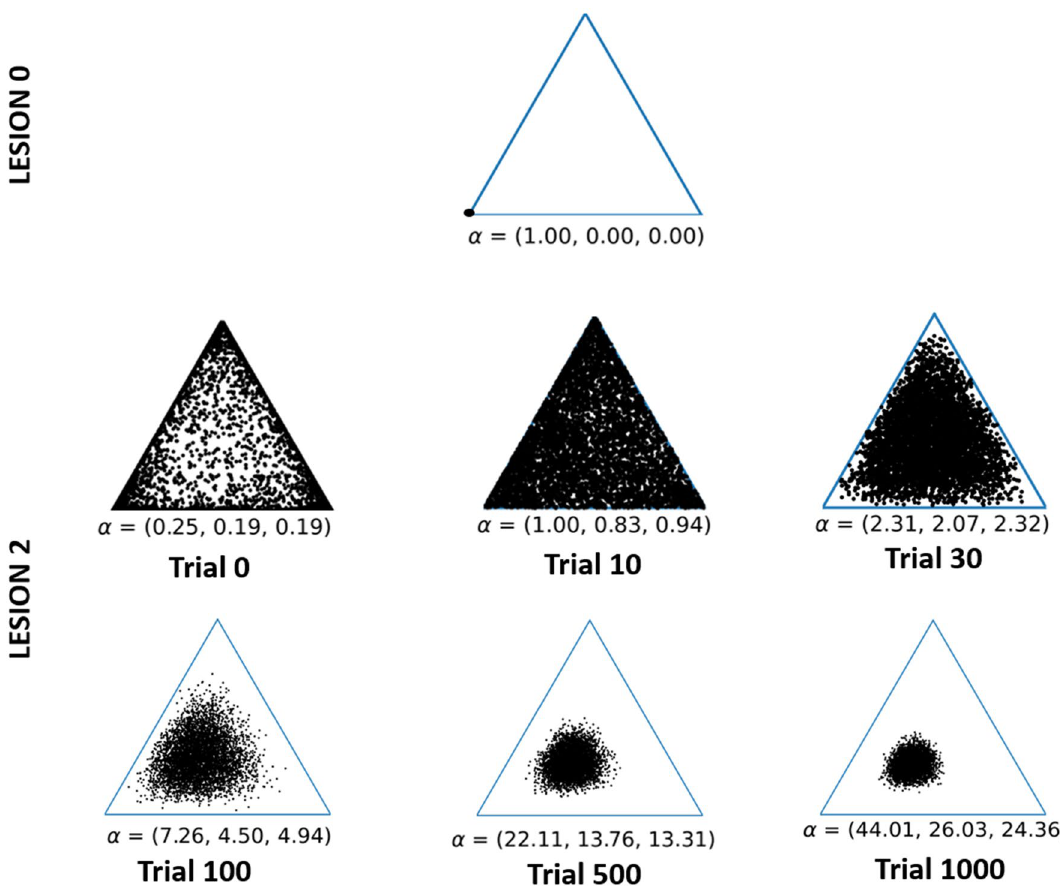
Figure 5. Synaptic strength changes via experience-dependent plasticity. The figure illustrates the Dirichlet distribution in a 3-dimensional coordinate space, i.e., 2-simplex for a particular simulation. The concentration of dots in one corner reflect precise beliefs; and scattered dots denote imprecise beliefs. Each dot represents a single sample from the Dirichlet distribution (determined by the alpha parameters), and each plot displays 5000 samples. For visual clarity, we have focused on the changes in the Target Word transitions for how the word ‘red’ can potentially transition to either ‘red’, ‘blue’ or ‘table’. Similar distributional shifts (i.e., learning) apply to other Target Word transitions. The plot for the control model illustrates that, with a precise transition mapping, the distribution is highly concentrated at one corner of the plot (to the extent that the points look like a single dot). On the second row, a series of panels illustrate the learning process for Lesion 2 over six time points (trials 0, 10, 30, 100, 500 and 1000). Immediately following the lesion (trial 0) a scattered distribution is evident, despite a higher concentration of points at all corners of the triangle. However, as the lesioned model learns (between trials 0 and 1000), the distribution converges to the corner associated with the high alpha—more closely resembling the